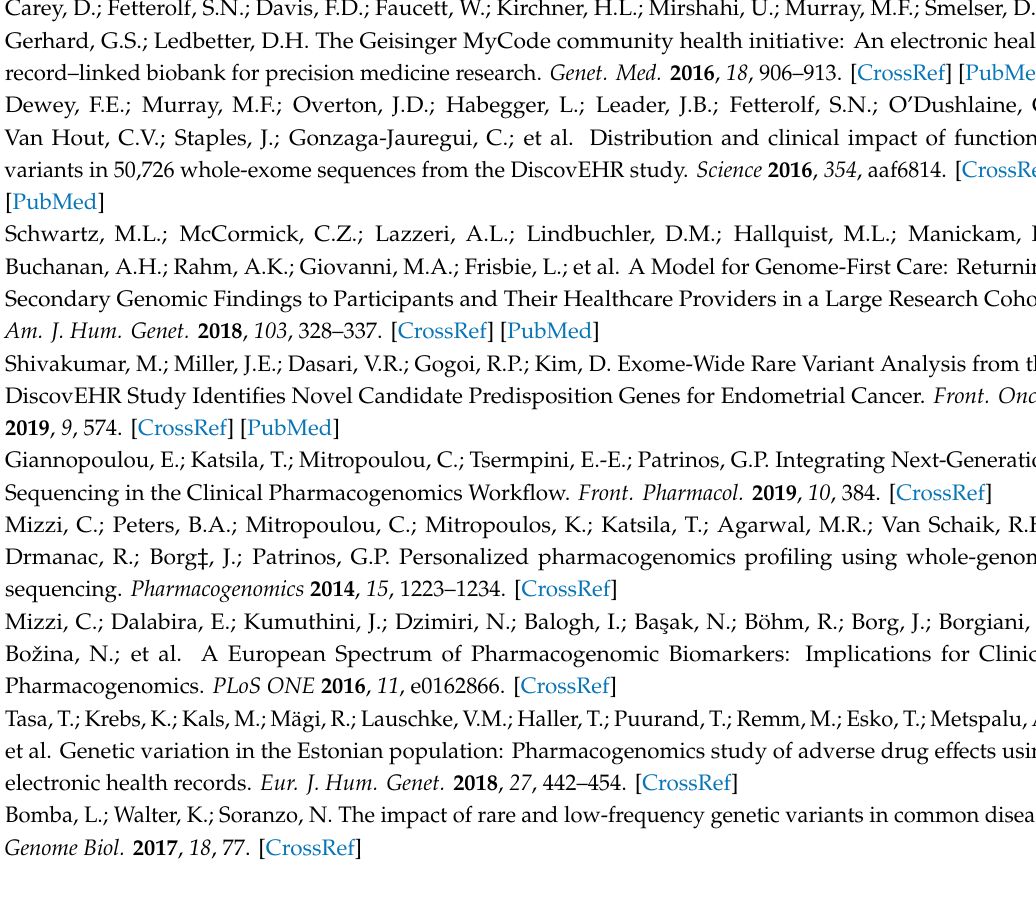
Figure S1: Count of protein damaging missense variants based on their frequency category: low frequency (0.01 =< MAF < 0.05), rare (0.001 <= MAF < 0.01), ultra-rare (MAF < 0.001); Figure S2: Boxplot of the MAFs (0–0.04%) of the protein damaging missense PGx variants, identified within the DiscovEHR cohort, within various gnomAD populations. Table S1: Presentation of the 231 pharmacogenes according to their HGNC symbol (taken from Arbitrio M, Di Martino MT, Scionti F, et al. DMET ™ (Drug Metabolism Enzymes and Transporters): a pharmacogenomic platform for precision medicine. Table S2: Count of shared PharmGKB variants between Lakiotaki et al. (2017) and DiscovEHR cohort according to the pharmacogene family and the VEP consequence based on Sequence Ontology terms. Table S3: Distribution of the 91 variants, which were found both in the DiscovEHR dataset and the gene-specific tables from PharmGKB, based on the VEP impact prediction and the protein function information as retrieved from